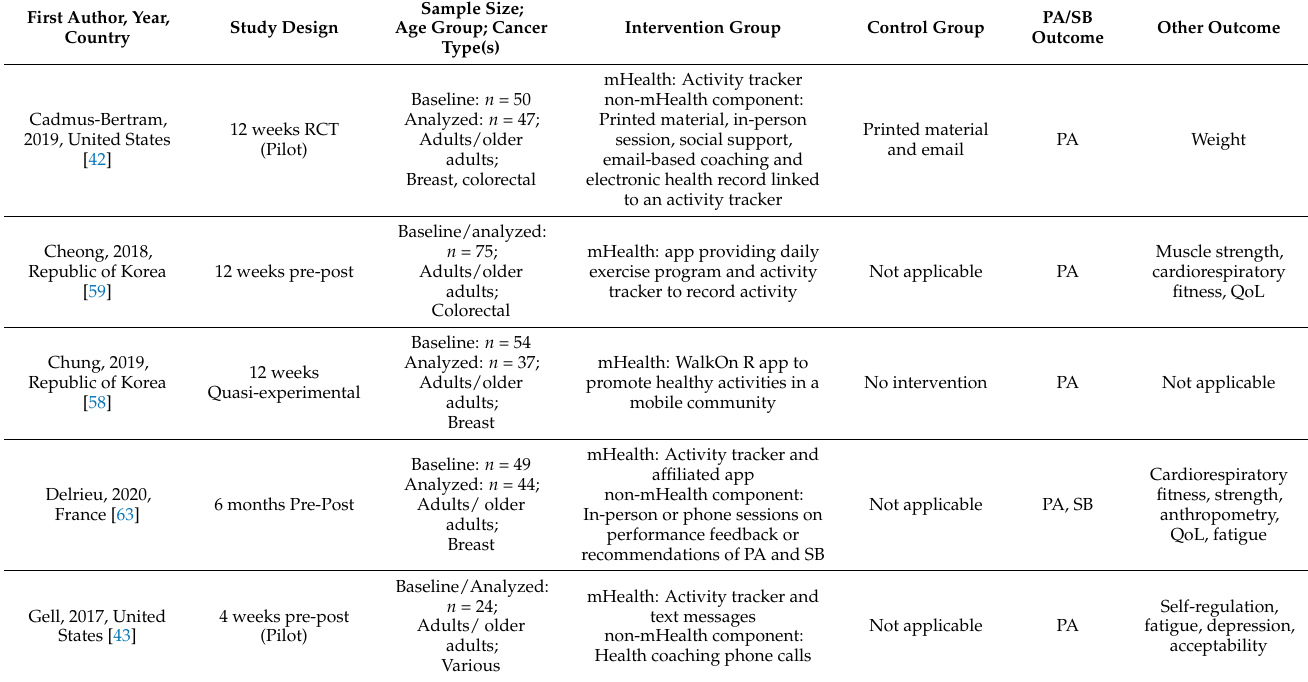
Table 1. Characteristics of included